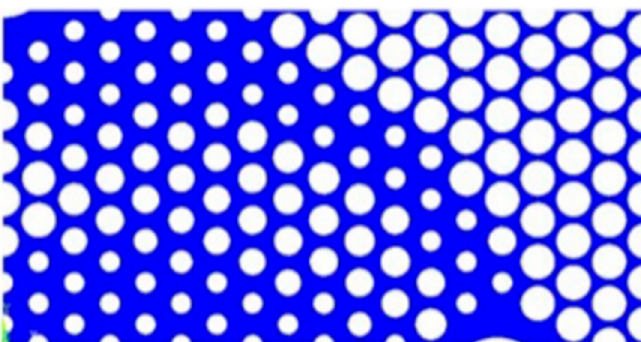
Figure 22. Non-uniform lattice structure based on HOC method [205].